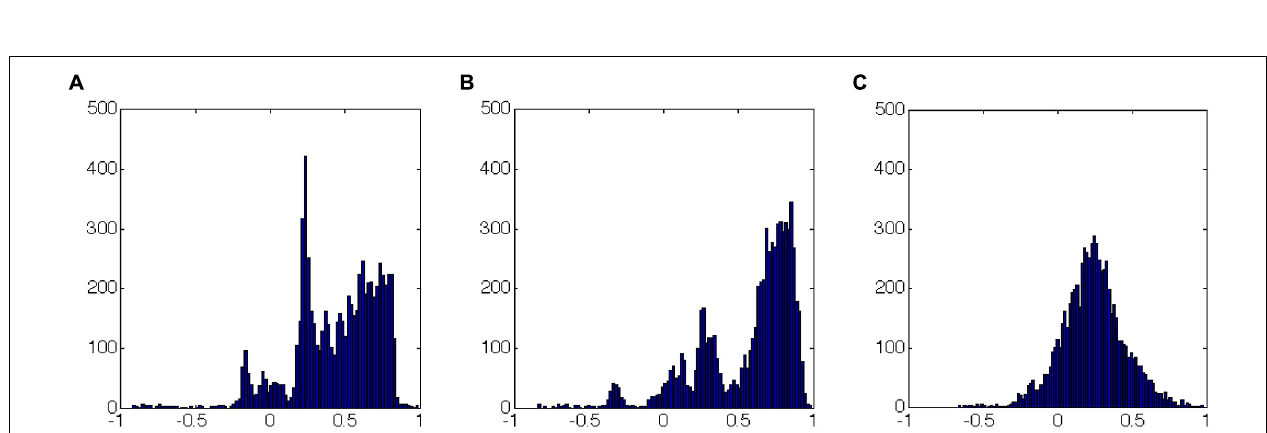
number and range of values) for the two similar rearing states ( A and B , sleep).This picture does not allow to specify if the same links (correlation between features) have similar values.